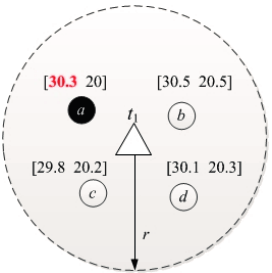
Figure 1. An example of the representative node selection and the provided services in the wireless sensor network.